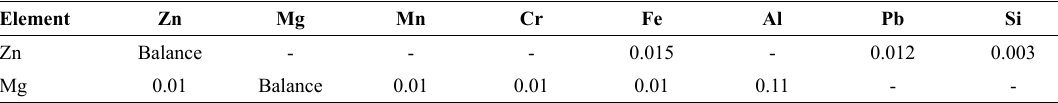
Table 1. Chemical composition of commercially pure Zn and Mg (wt.%)